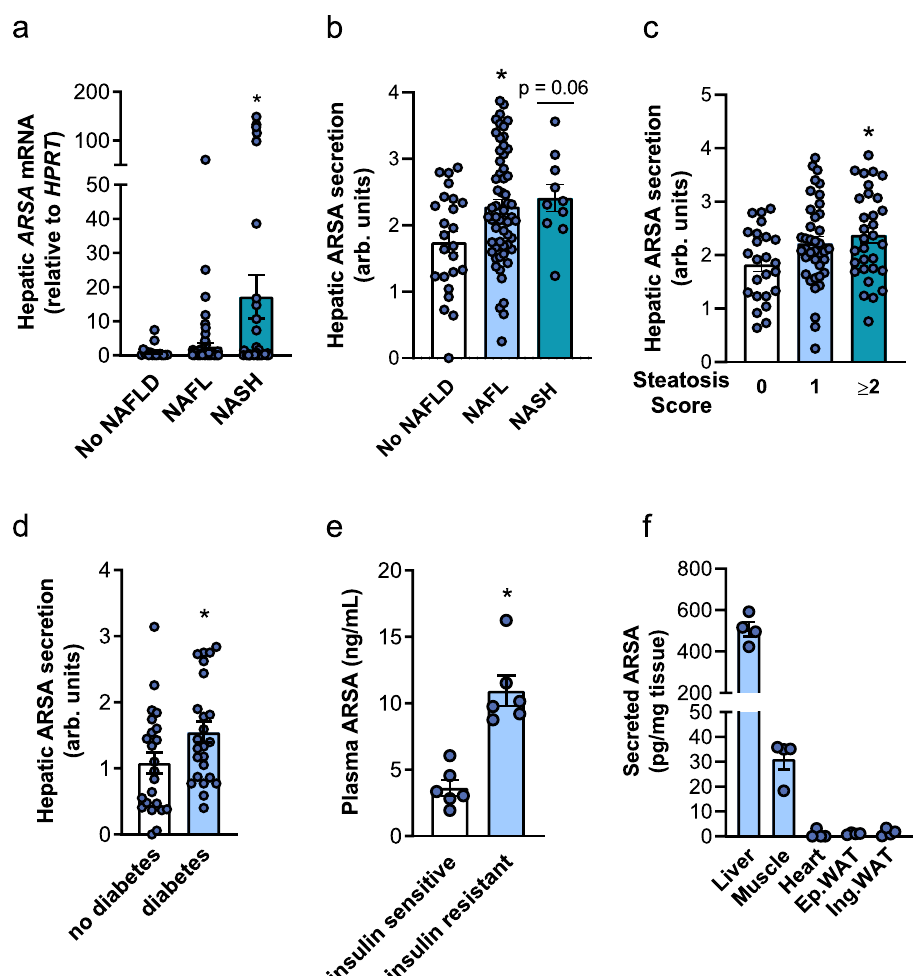
Fig. 2 ARSA expression and secretion in humans with NAFLD/NASH and type 2 diabetes. a ARSA mRNA expression in patients grouped by no adverse pathology (i.e., No NAFLD, n = 17, white bar), NAFL ( n = 66, light-blue bar) or NASH ( n = 43, dark-blue bar). * P = 0.047 No NAFLD vs. NASH. b – d ARSA secretion from precision-cut liver slices in patients grouped by ( b ) No NAFLD ( n = 24, white bar), NAFL ( n = 58, light-blue bar) or NASH ( n = 10, dark- blue bar). * P = 0.016 No NAFLD vs. NAFL, P = 0.064 No NAFLD vs NASH. c steatosis score (0, n = 24; 1, n = 39; ≥ 2, n = 31), P = 0.112 score 0 vs. score 1, * P = 0.022 score 0 vs. score >2. d type 2 diabetes status (no diabetes n = 23, white bar; diabetes n = 24, blue bar), * P = 0.047 no diabetes vs. diabetes. ( n = 6/group), * P = 0.0002. f ARSA secretion from mouse precision-cut liver slices, intact tendon-to-tendon extensor digitorum longus (EDL) and soleus skeletal muscles (combined conditioned media denoted as muscle), precision-cut heart slices, and epididymal and inguinal adipose tissues ( n = 4/group). For all panels, data are means ± SEM. * P < 0.05 vs. No NAFLD, no diabetes, insulin-sensitive as assessed by one-way analysis of variance (ANOVA)